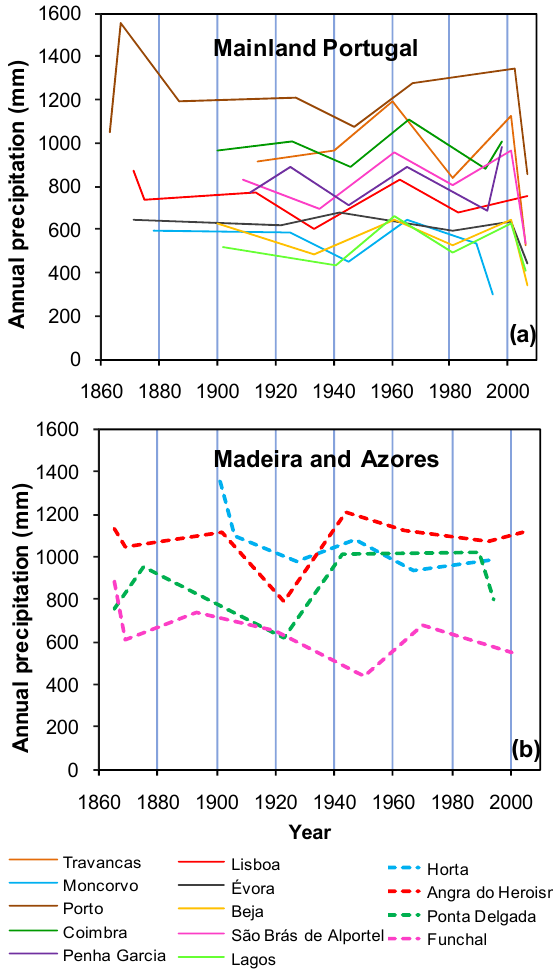
Fig. 4. Partial trend fits to the annual precipitations for: (a) ten locations in mainland Portugal (adapted from de Lima et al., 2010); (b) four locations in the Madeira and Azores archipelagos. The time series are not plotted.